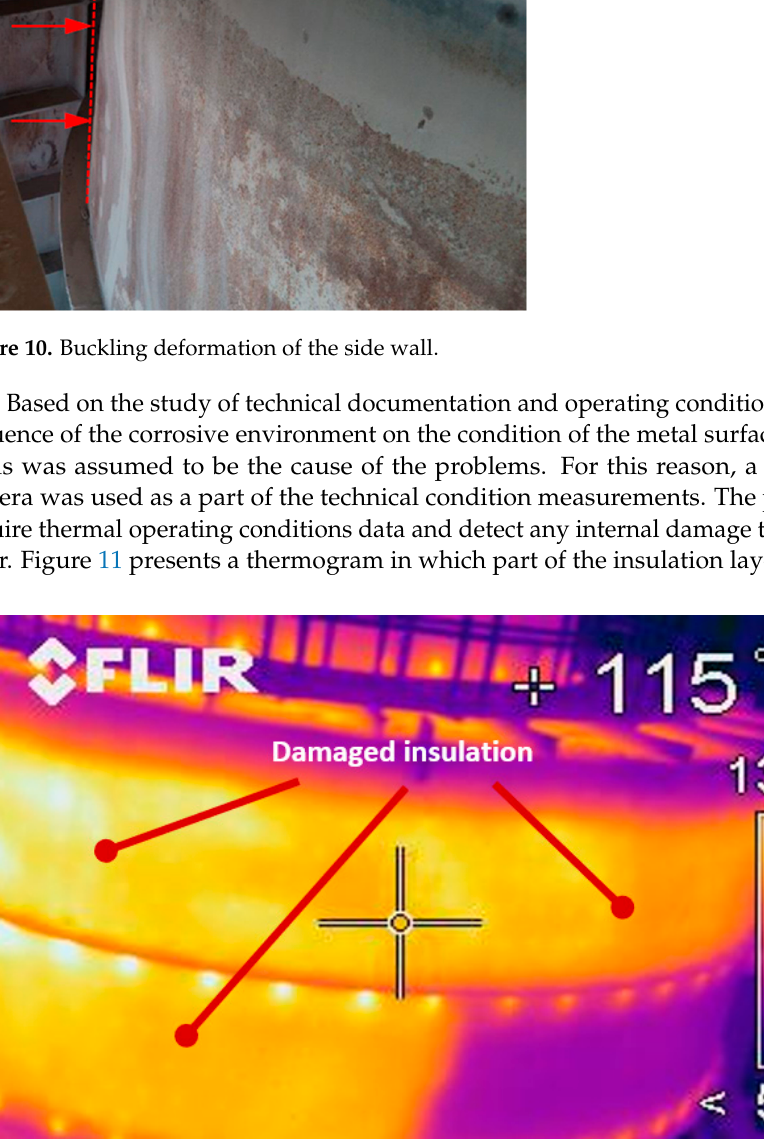
Figure 11. Thermogram of the damaged insulation layer region.